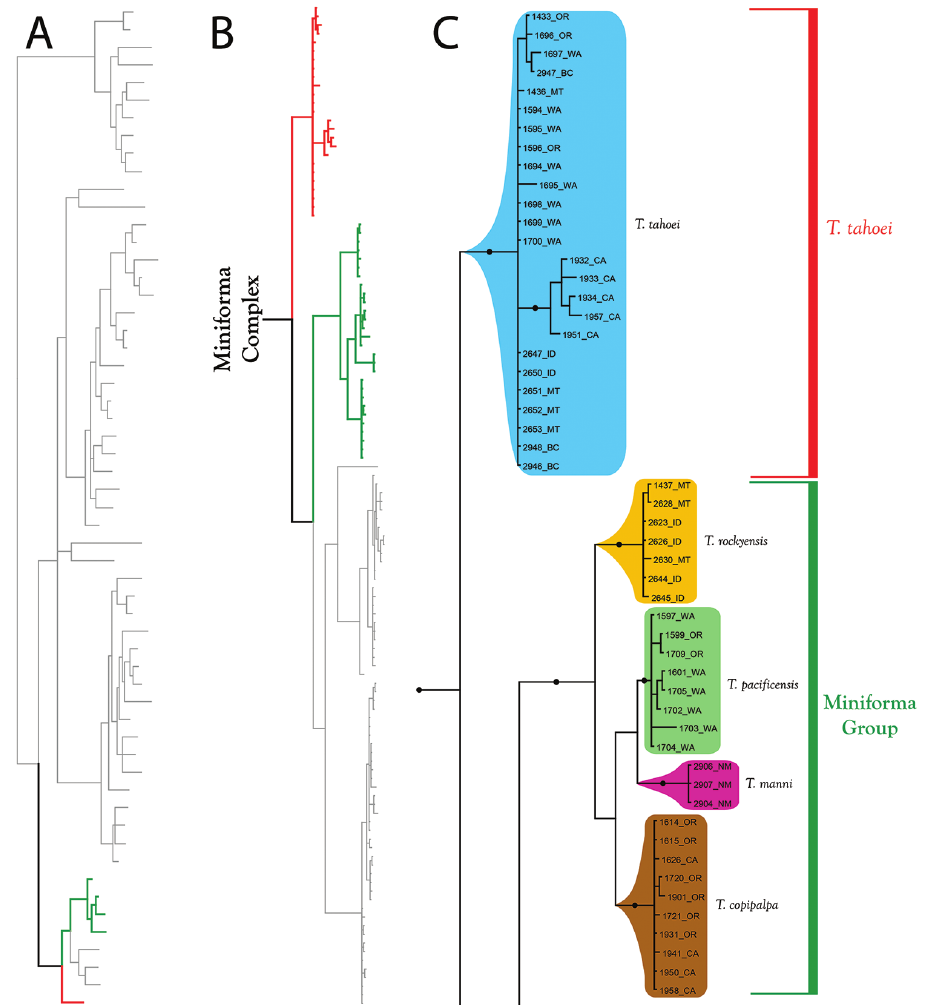
Figure 12. Miniforma Complex (part I). All species are western. Note that the phylogenetic structure in the Miniforma Group corresponds to biographic regions (Rockies, Pacific Ranges, southwest). A Species guide (overview of 28S+COI analysis from Figure 7–8) B Overview of Miniforma Complex from Figure 9 (COI-only analysis from Figure 9) C Detail of Miniforma Complex (in part) from B C Detail of Mini- forma Complex (in part) from Figure 9. Colored lineages in A and B correspond to Group names and brackets in C. Dots denote posterior probably of greater than 95%. Taxa are displayed by DNA number and state (U.S.) or territory (Canada)